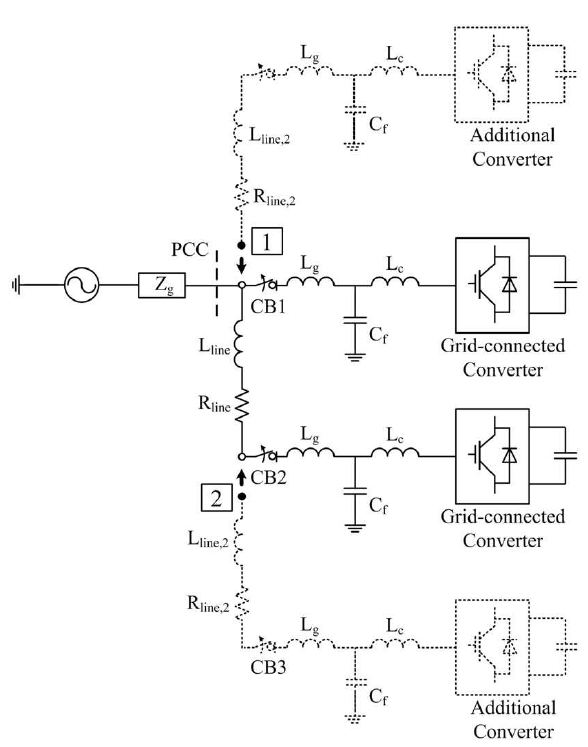
Figure 9. AC system configuration of a converter-connected grid with the additional converter to be installed.